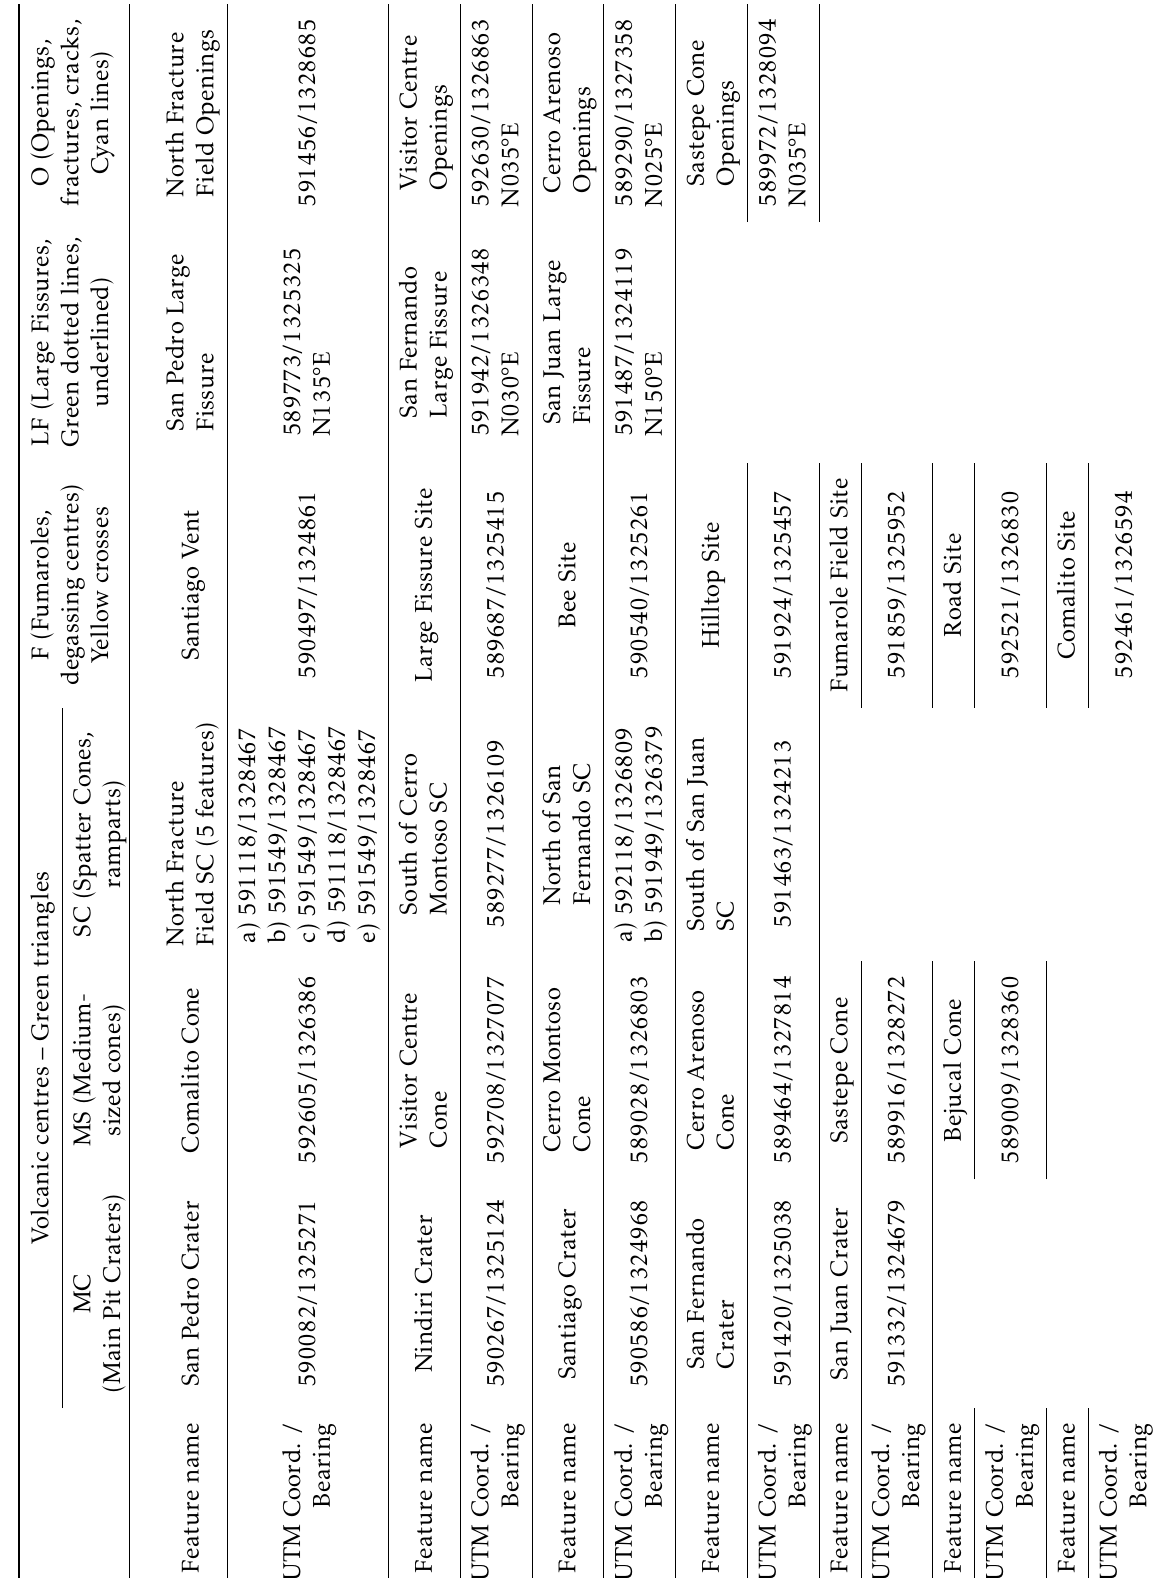
Table A1 – Structural features and locations displayed (as numbered abbreviations) in Figure 2. UTM coordi- nates (zone 16P) correspond with the centre (or midpoint in linear features) of the respective structures, with predominant bearing specified if